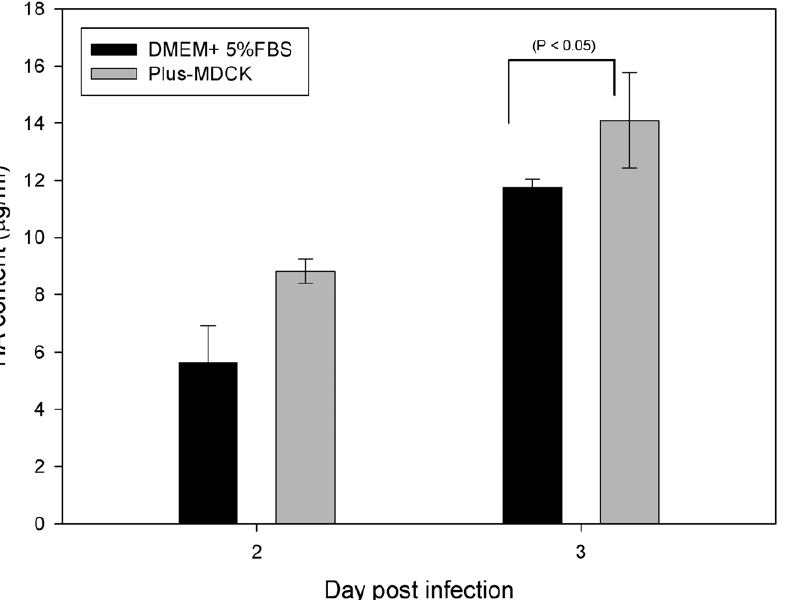
Figure 3. Production of HA antigens produced either in SC or SF medium. Samples taken from the 7.5 L bioreactor during the infection period were analyzed for HA antigen content. The harvest of HA antigen reached a peak at 14.1 m g/mL on day 3 post infection, as determined by SRID assay. By contrast, the harvest from the SC medium was 12.7 m g of HA/mL. doi:10.1371/journal.pone.0014578.g003 PLoS ONE |